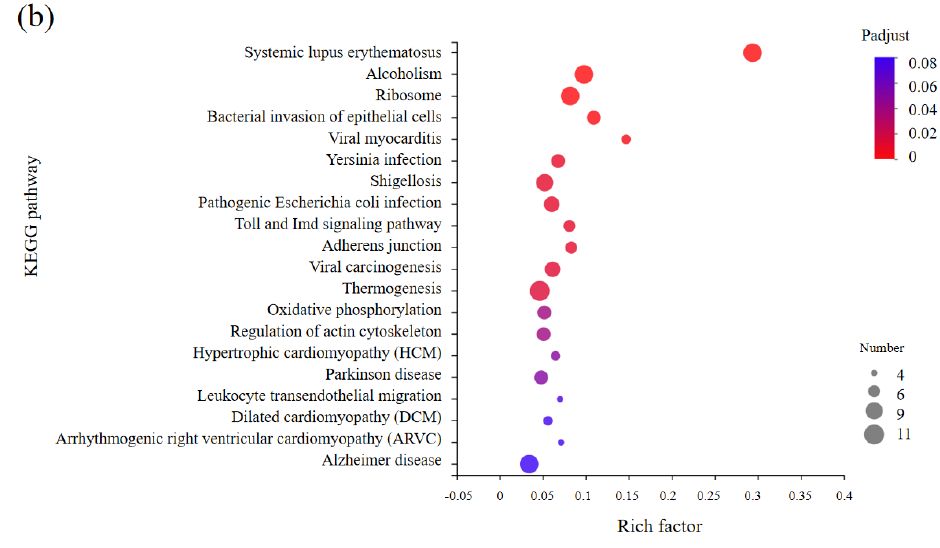
Figure 6. Top 20 pathways of KEGG enrichments analysis. ( a ) DEGs in CK4h_vs._DH4h group; ( b ) DEGs in CK12h_vs._DH12h group. The vertical axis represents pathway name and the horizontal axis represents rich factor. A greater rich factor indicates a greater degree enrichment. The size of the plot represents the number of DEGs in this pathway. The color of the plot corresponds to different p −adjust ranges.